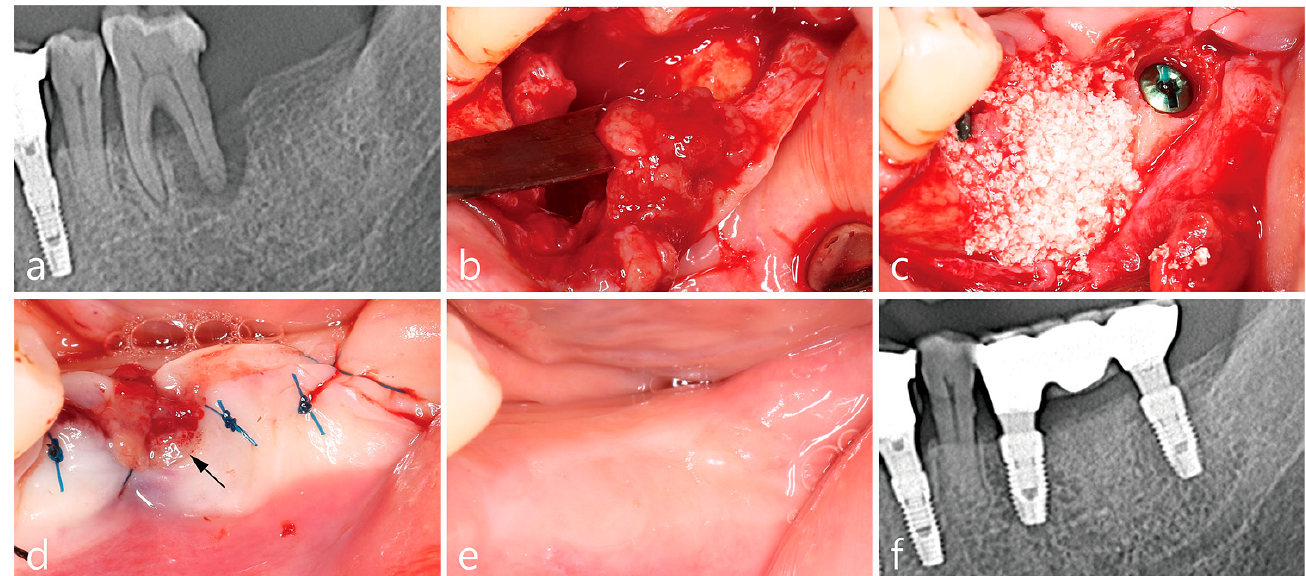
Figure 5. Clinical and radiological findings of case #5. ( a ) Pre-operative panoramic radiograph showing severe bone resorption around #36. ( b ) Flap extension by dissection of the ICT attached to the buccal flap with the base attached to the existing flap. ( c ) Bone graft placement over #36 implant. ( d ) Flap closure with extended IGT. ( e ) Post-operative photograph showing healing with no flap exposure. ( f ) Panoramic radiograph taken 19 months after prosthesis delivery.